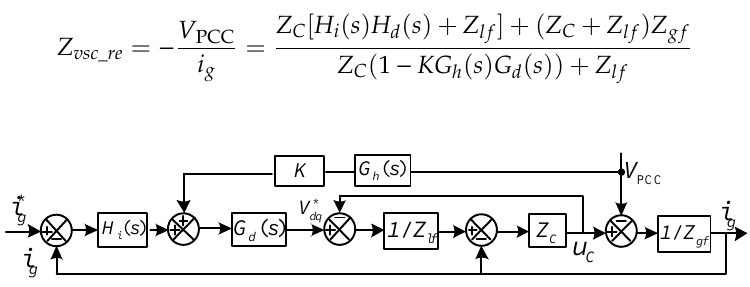
Figure 7. Control block of VSC system with the PCC voltage feedforward.